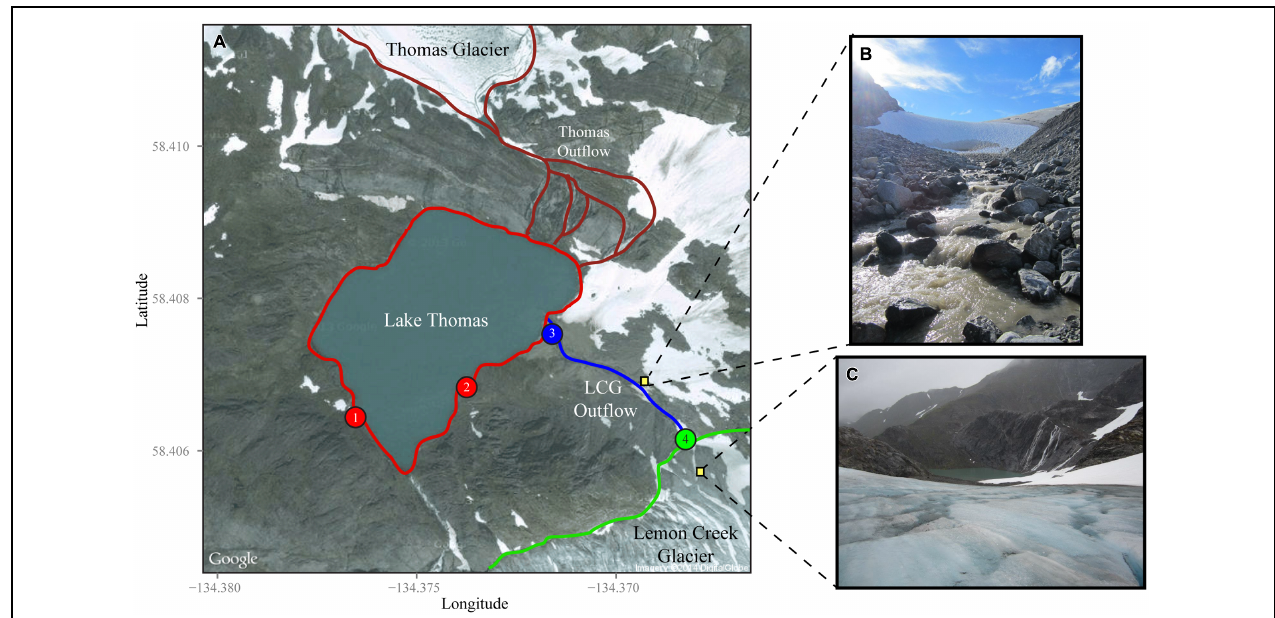
FIGURE 1 | Overview of sampling locations at Lemon Creek Glacier (LCG). (A) Satellite image taken from Google Maps shows sampling locations, Lake Thomas (red), LCG outflow and runoff (blue), and LCG terminus outflow (green). Numbers within the filled circles correspond to